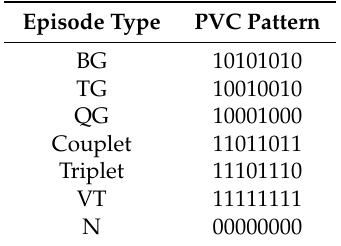
Table 2. PVC patterns of various episodes.